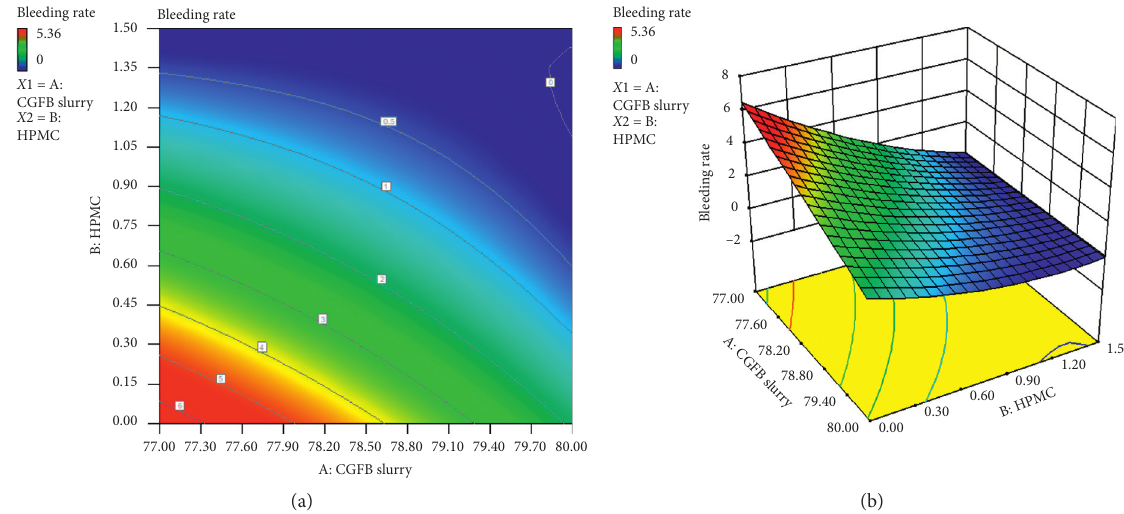
Figure 8: Response surface plot of bleeding rate. (a) Two-dimensional diagram. (b) Three-dimensional